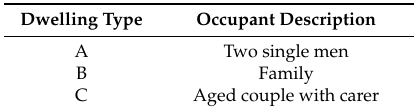
Table 1. Dwelling types and occupants.